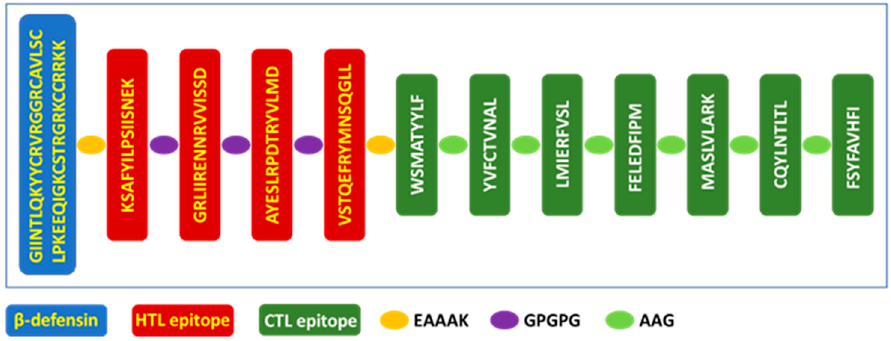
Figure 6. Amino acid sequences of the VC. Beta defensin (was used as adjuvant, HTL epitopes, and CTL epitopes were connected using linkers EAAAK, GPGPG, and AAG. CTL epitopes were connected using linkers EAAAK, GPGPG, and